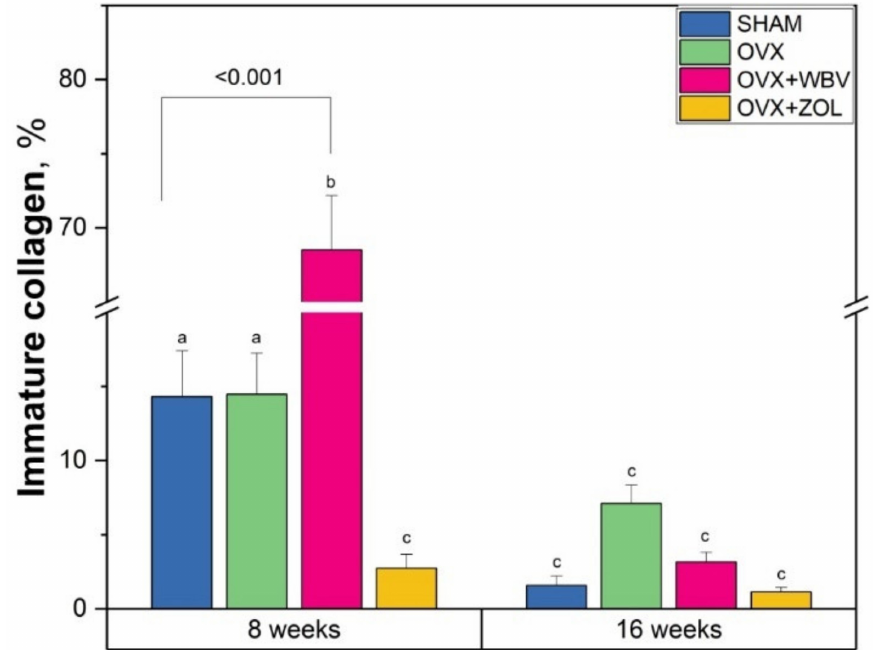
Figure 2. Immature collagen content in femora trabeculae of controls (SHAM surgery), ovariec- tomized rats (OVX), ovariectomized rats with whole body vibration (OVX + WBV), or Zoledronic acid (OVX + ZOL). Data are presented as mean ± SE. Statistically significant differences between groups are indicated by a, b and c letters as shown by two-way ANOVA with Tukey’s post hoc test ( p < 0.05). Brackets show statistically significant results of Dunnett’s test post-hoc performed to evaluate the differences between the experimental groups and the corresponding sham operated controls